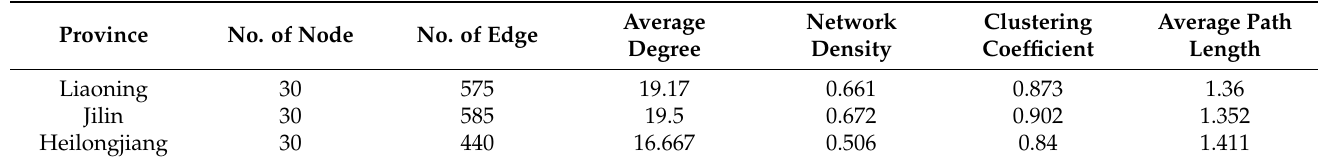
Table 2. Results for structural characteristic indicators of ECETNs.